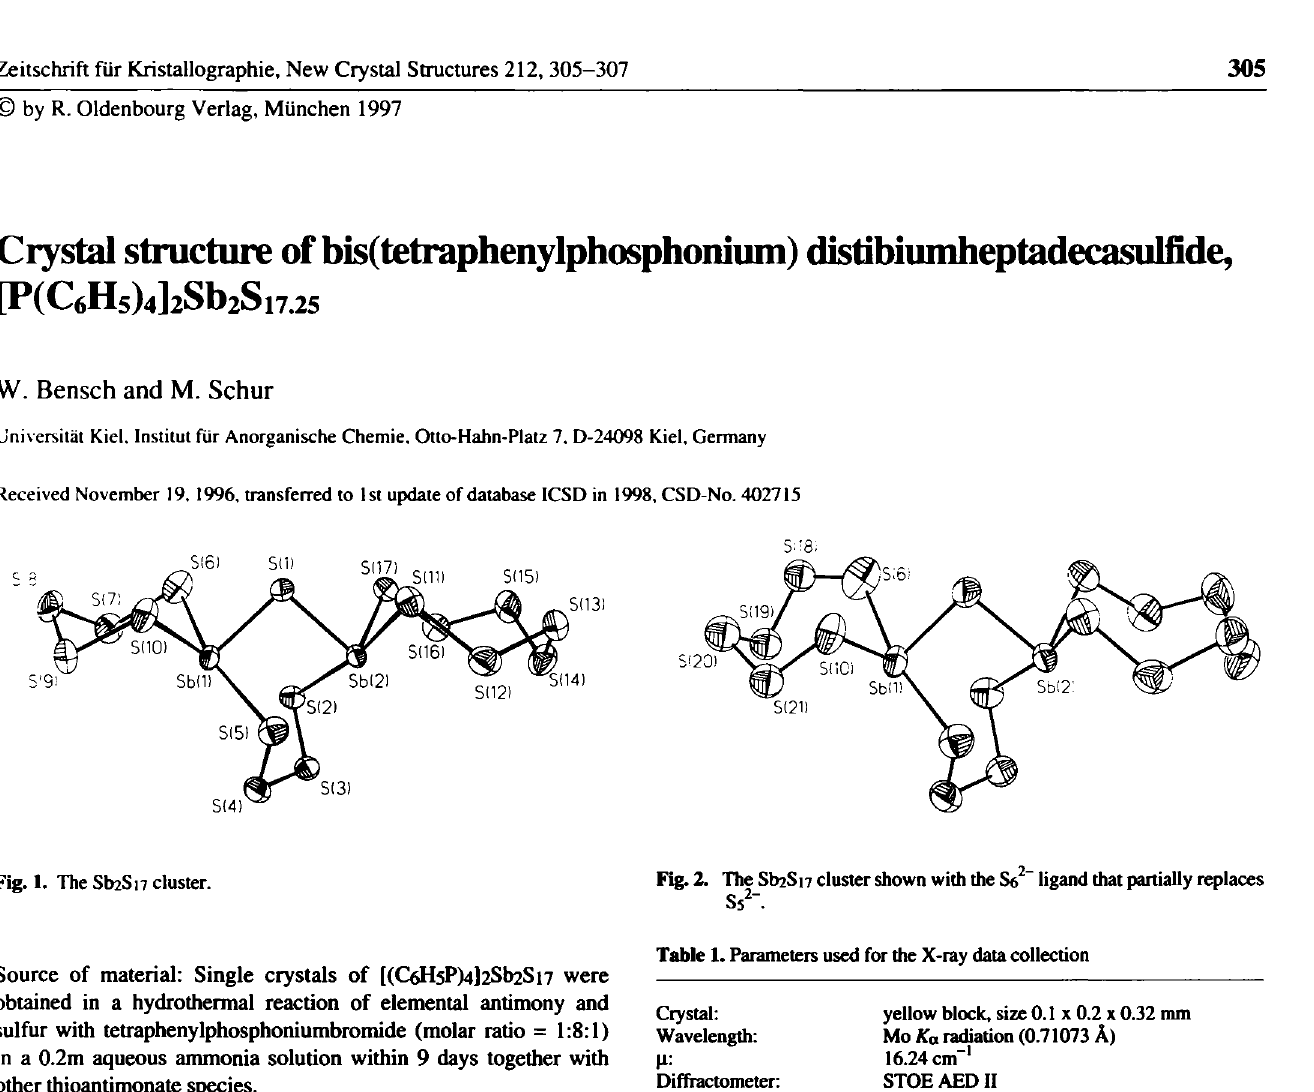
Ss 2 ". Table 1. Parameters used for the X-ray data collection Crystal: